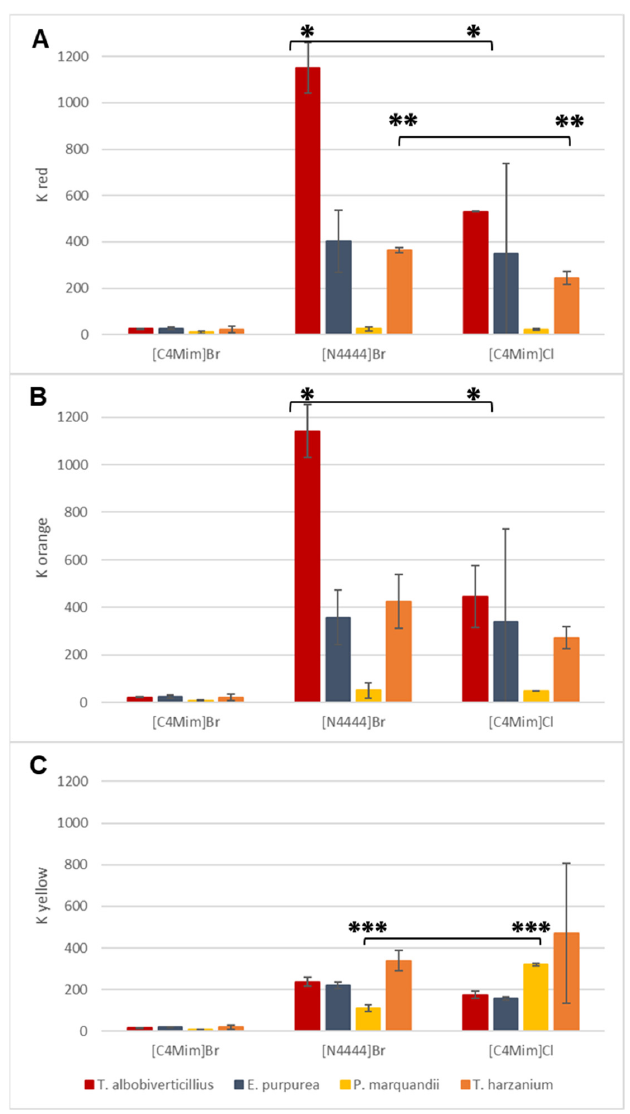
Figure 4. Partition coefficients of red (490 nm) ( A ), orange (470 nm) ( B ) and yellow (400 nm) ( C ) pigments for each strain in the four IL-ATPSs tested (*, ** and *** stand for statistical significance based on p -values < 0.05 performed for the same strain treated with different IL-ATPSs, n = 3). In parallel, the repartition coefficient for yellow pigments remained drastically smaller than repartition coefficient for red, K red, across all ATPSs as well as amongst all fungal strain productions. Even the bright-yellow-pigment-producing fungal strain, namely P. marquandii , did not generate partition coefficient values as high as red-pigment-producing fungal strains (i.e., T. albobiverticillius and E. purpurea ) for red to orange pigments. Such limited results for yellow compounds could be explained by the fact that reddish and orangish pigment-producing fungal strains may simply not produce many actual yellow molecules. In the case of the strong yellow-producing strain of P. marquandii , although the pigments clearly migrated to the ionic liquid-rich phase, the raw data of absorbance measured at 400 nm (yellow typical wavelength) were globally four times weaker in